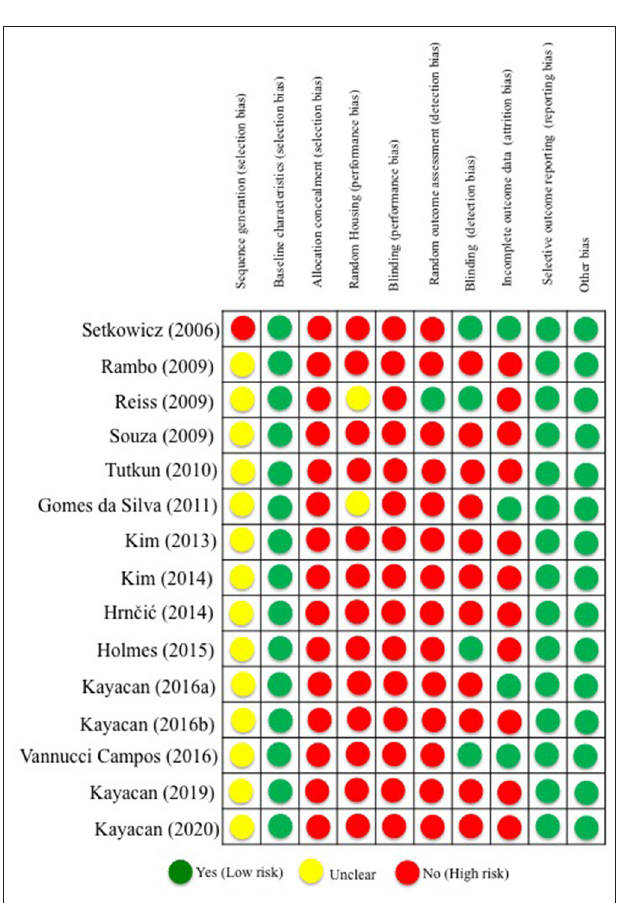
FIGURE 3 | Risk of bias assessment of selected